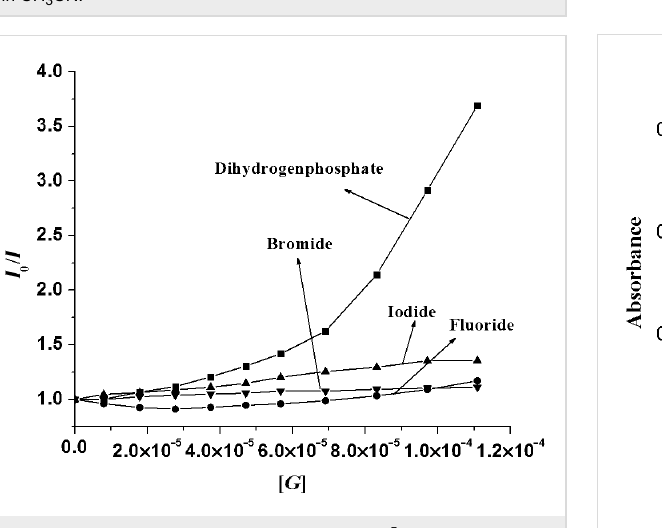
Figure 9: Stern–Volmer plots for 1 ( c = 5.78 × 10 − 5 M) with H 2 PO 4 − , F − , Br − and I − at 420 nm (up to the addition of 2 equiv of guest) in CH 3 CN.